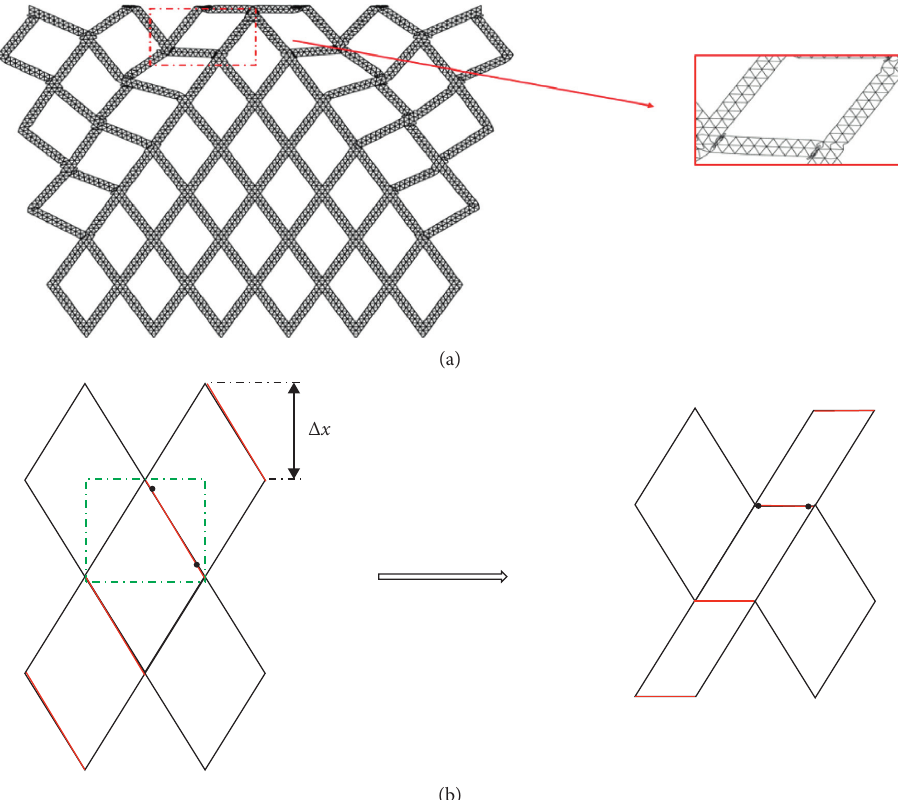
Figure 9: (a) Enlarged DHH deformation diagram, N � 12, ρ � 5%, and ε � 10%. (b) Schematic of the deformation of the subunits under impact loading in the z